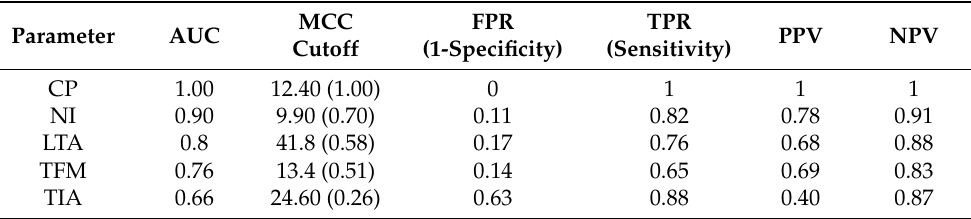
Table 2. ROC measures including AUC or ROC space and MCC cutoff values for the four radiographic parameters. The MCC cutoff column shows the cutoff values, with the MCC values in